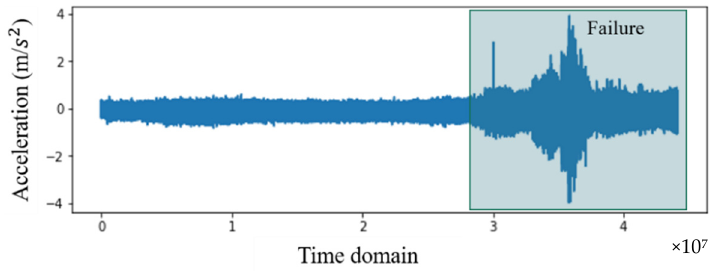
Figure 3. Raw data for case 1.